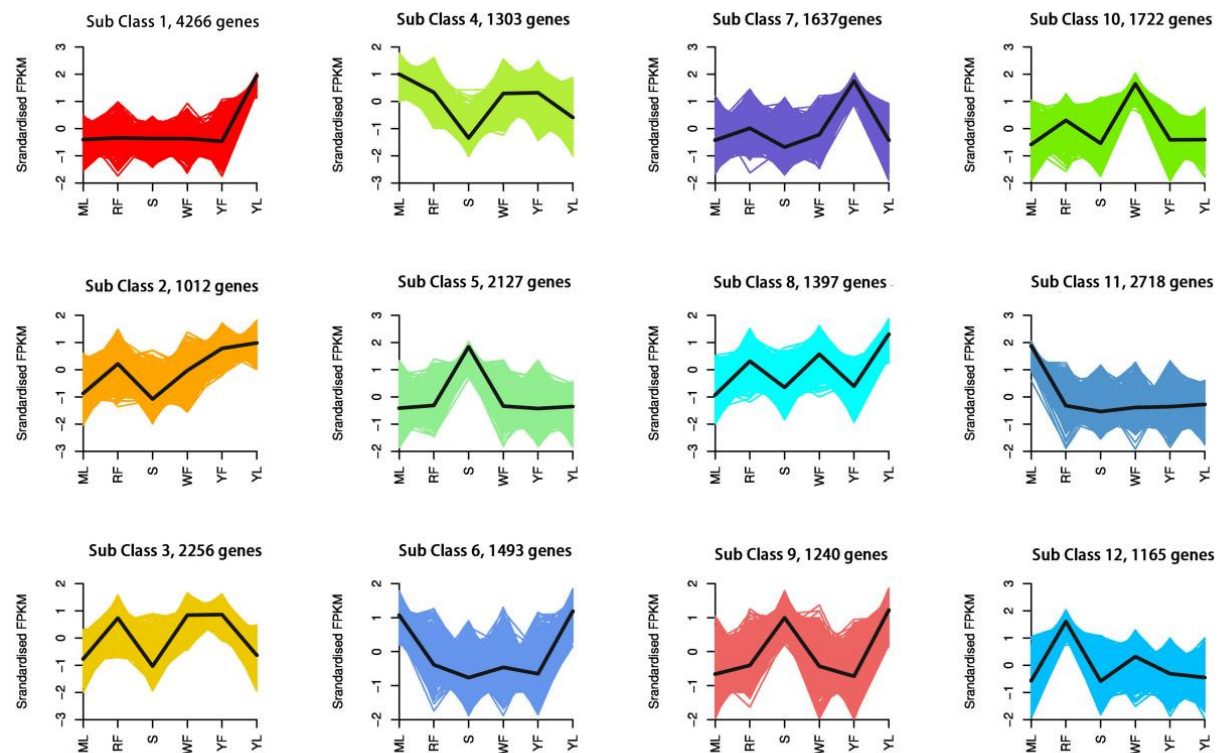
Figure 3. Clusters of DEGs. Twelve clusters were classified based on gene expression pattern: Sub Class1–Sub Class12. The horizontal coordinate represents the sample and the vertical coordinate represents the centralized and normalized expressions.